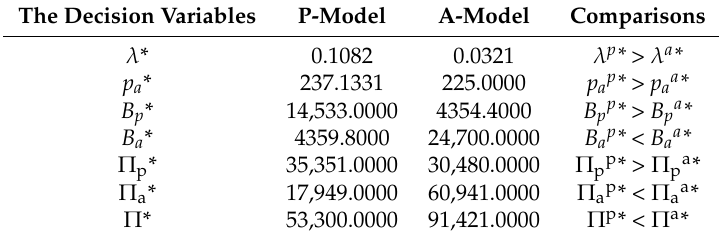
Table 3. Optimal equilibriums and profits of the platform and the advertiser in two models in Exp. 3. The Decision